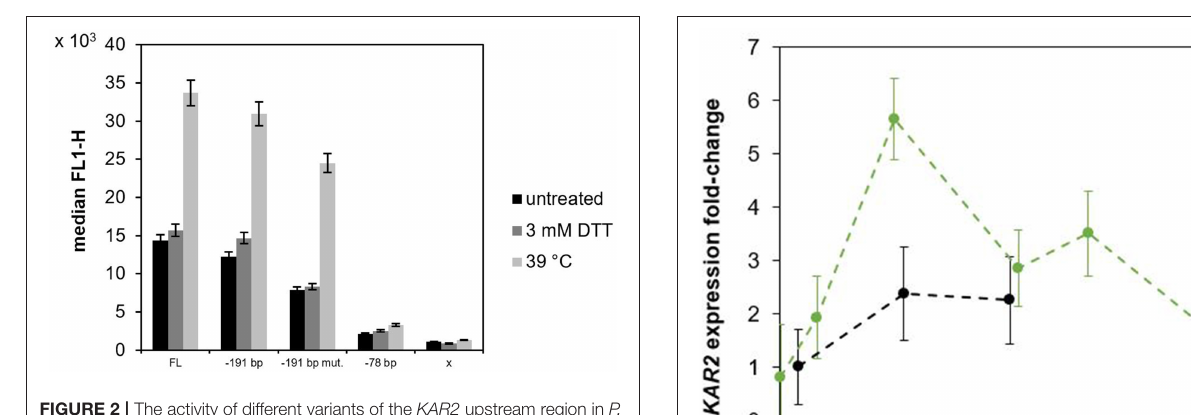
FIGURE 2 | The activity of different variants of the KAR2 upstream region in P. pastoris X33. The promoter activity of the different variants of the KAR2 upstream region was measured as a green fluorescence of sfGFP (channel FL1) with flow cytometry, as the gene of sfGFP was inserted downstream of the KAR2 upstream region. A variant with no promoter in front of the sfGFP gene (x) was used as a negative control. P. pastoris strains with the different variants of the KAR2 upstream region (FL, − 190 bp, − 190 bp mut., − 77 bp) controlling sfGFP expression, and the negative control strain ( x-sfGFP ) were cultured overnight in shake flasks with YPD, then split into three parallels and further incubated for another 2h. One parallel was cultured under normal conditions without experimental stress (black bars), the second parallel was cultured in the presence of 3mM DTT (dark gray bars) and the third parallel was cultured at an increased temperature of 39 ◦ C (light gray bars). The displayed values are median FL1 values of all events belonging to a gate defined in a FSC-SSC dot plot (distinguishing P. pastoris cells from the background, data not shown). The error bar is showing a standard deviation of three measurements.